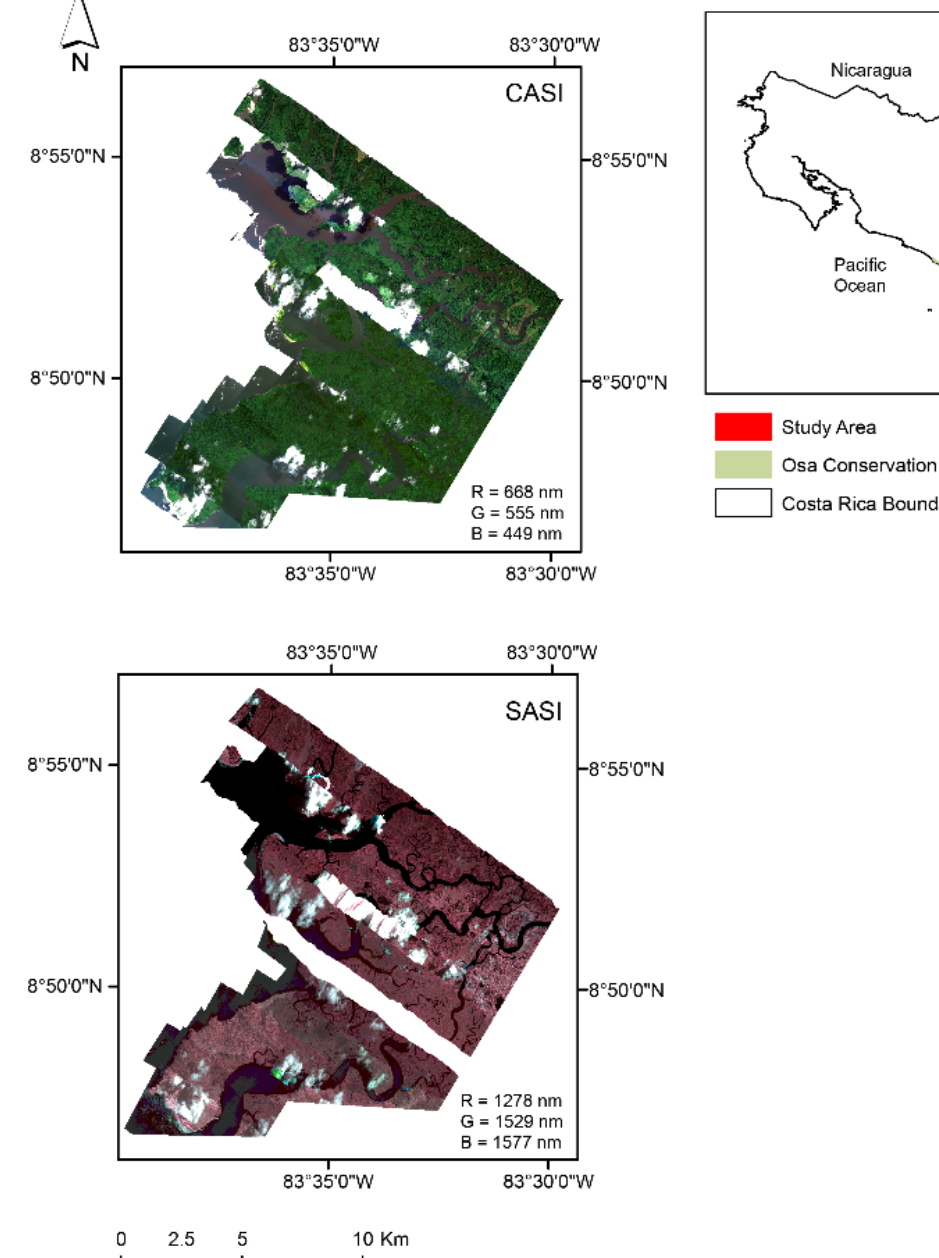
Figure 1. Térraba-Sierpe mangrove forest ecosystem located on the Osa Peninsula, Costa Rica. The map contains two mosaics: A mosaic of imagery acquired with the Compact Airborne Spectrographic Imager–CASI 1500 (R = 668 nm G = 555 nm B = 449 nm) and a mosaic of imagery acquired with Shortwave Airborne Spectrographic Imager–SASI 644 (R = 1278 nm G = 1529 and B = 1577 nm).